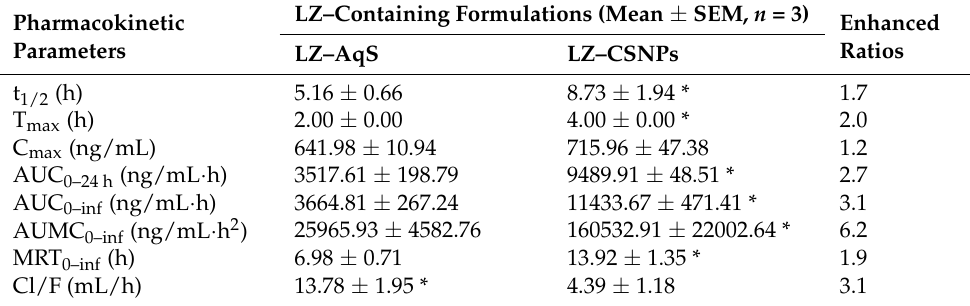
Figure 7. The drug concentration–time profile of aqueous humor (AqH) samples collected from rabbit eyes post topical application of LZ–AqS and LZ–CSNPs. Results were represented as the mean of three readings (three rabbits per group) with standard error of mean (Mean ± SEM). The “*” representing p < 0.05 was the level of significance between the two drug products. Table 8. Ocular pharmacokinetics of LZ after topical application of LZ–containing formulations. Data were represented as the mean of three measurements with standard error of mean (Mean ± SEM, n =